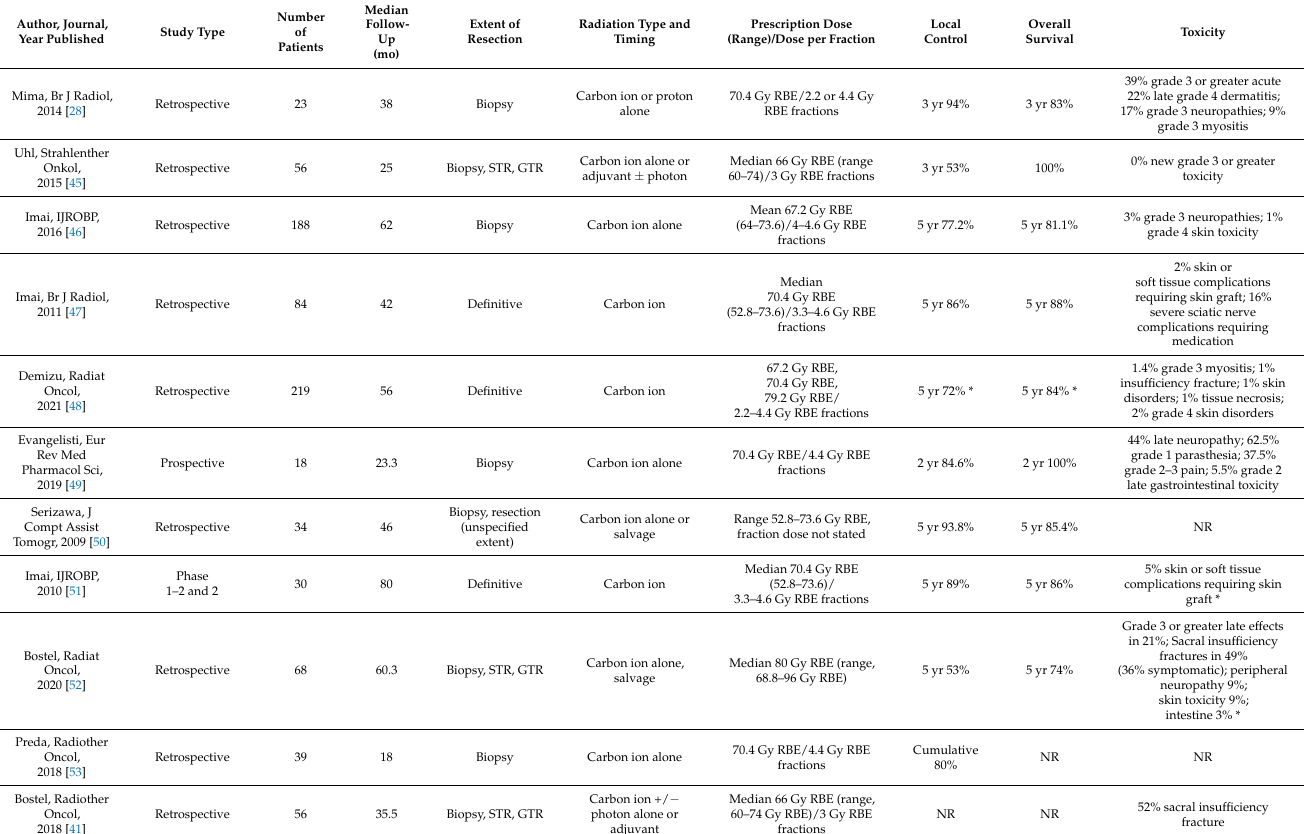
Table 2. Data summary of studies reporting outcomes of patients with spinal and sacral chordomas treated with carbon ion and other heavy particle